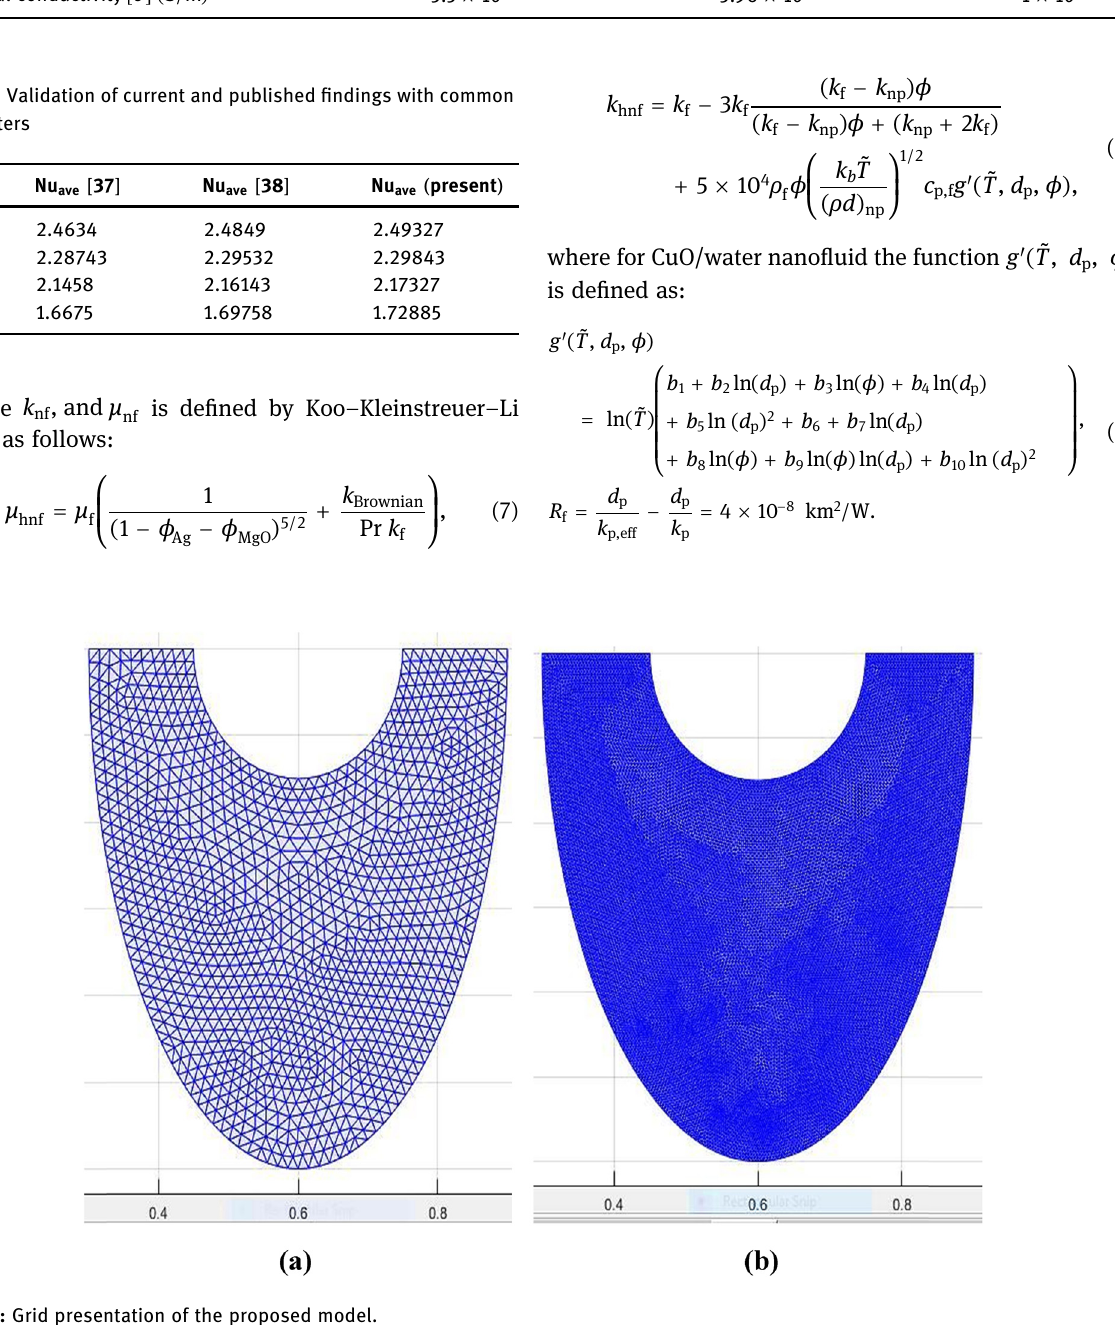
Figure 1: Grid presentation of the proposed